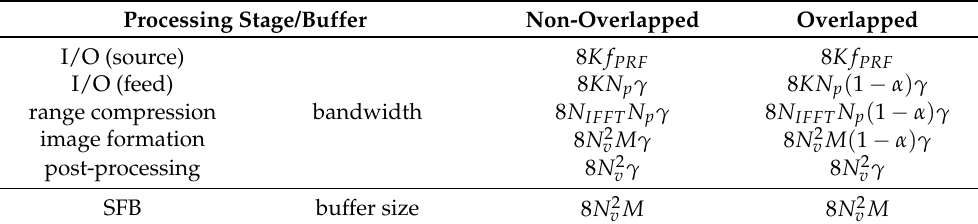
Table 5. Bandwidth in the BP-VISAR architectures with sub-aperture